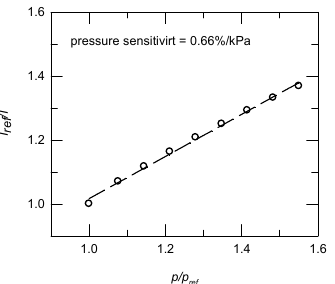
Figure 5. PSP measurement system.